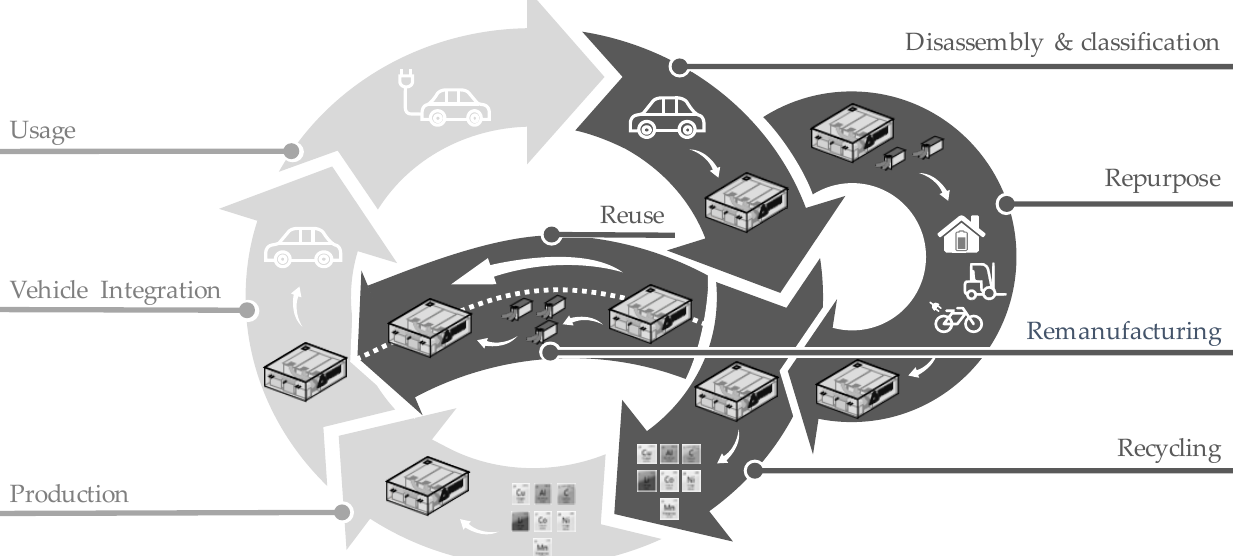
Figure 1. The ideal battery lifecycle with the four pathways for an efficient circular economy approach based on [5].